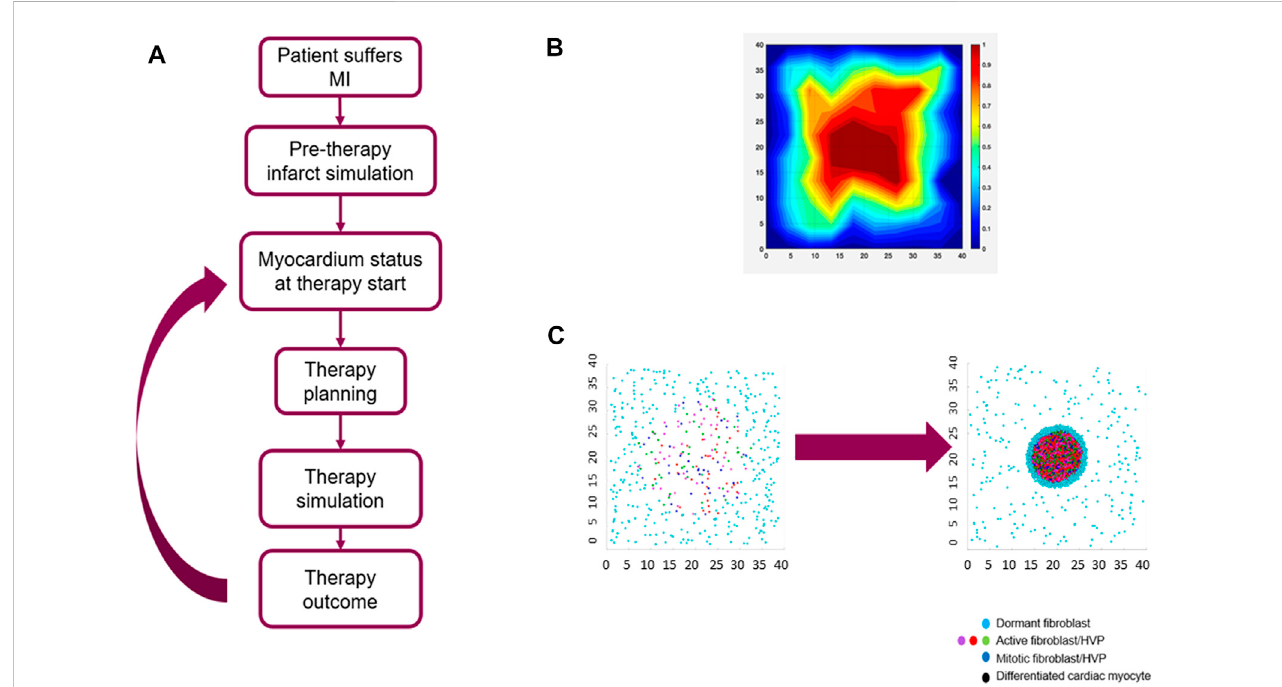
FIGURE 4 Agent-Based Model (ABM) of myocardial infarction (MI) and human ventricular progenitor (HVP) therapy. (A) clinical HVP therapy modeling and simulation work fl ow; (B) collagen area fraction predicted by the ABM at the end of the acute remodeling phase of myocardial infarction; (C) simulation example of HVP proliferation and differentiation: initial stage before HVP injection where only host fi broblasts are present (left) and fi nal stage after HVP injection where a mixture of host fi broblasts and HVPs are present (right). Size of the simulated domain (shown in mm) is 4 × 4